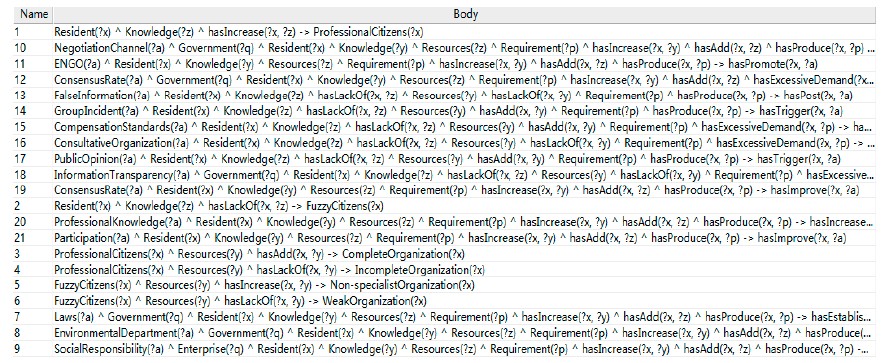
Figure 8. The rule base in Protégé. Table 2. SWRL-based rule base.